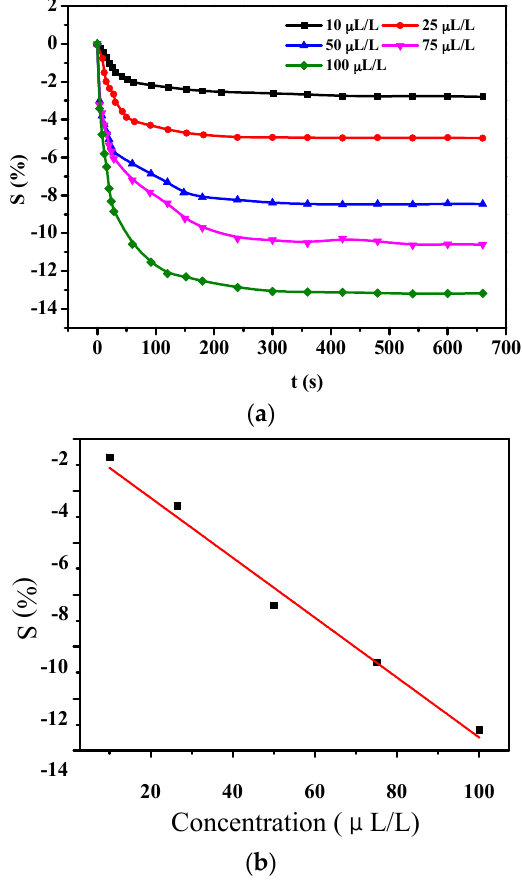
Figure 7. Gas-sensing response of PANI-SSA sensor to SO 2 of different concentration. ( a ) Response to various concentration of SO 2 ; ( b ) Liner dependence between sensitivity and gas concentration.